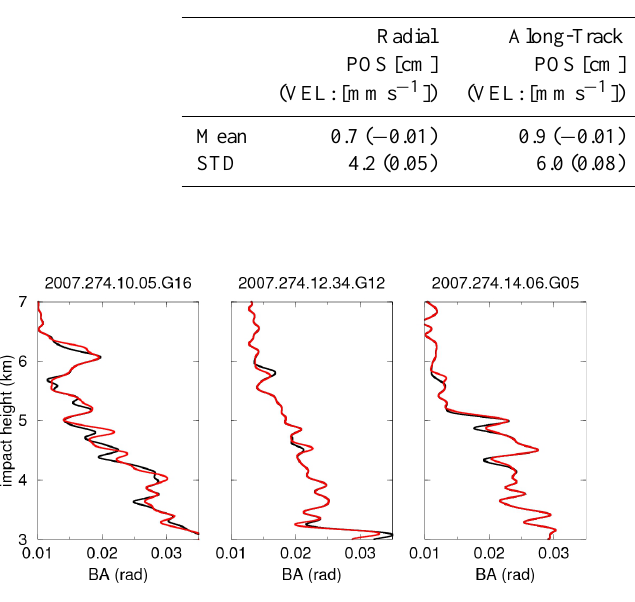
Table 1. Summary of Metop/GRAS external orbit overlap comparison between UCAR and EUMETSAT for 2007.274-305.